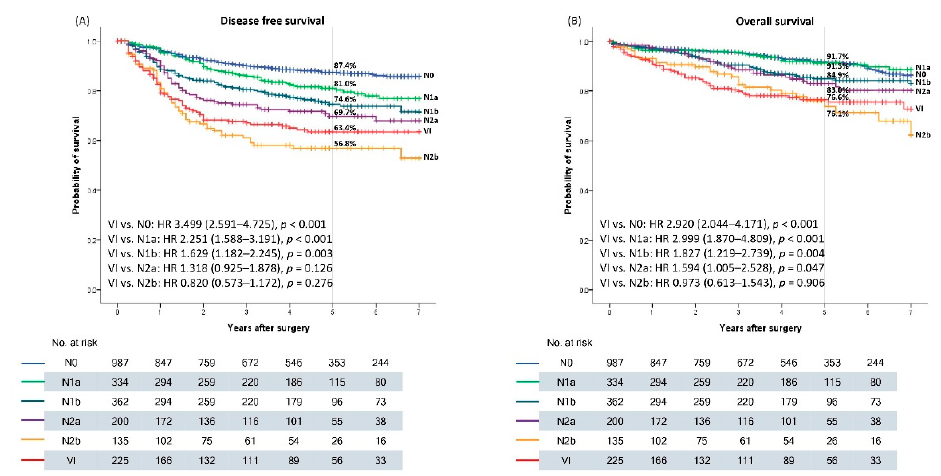
Figure 1. Kaplan–Meier curve according to the study groups indicating ( A ) disease-free survival and ( B ) overall survival.